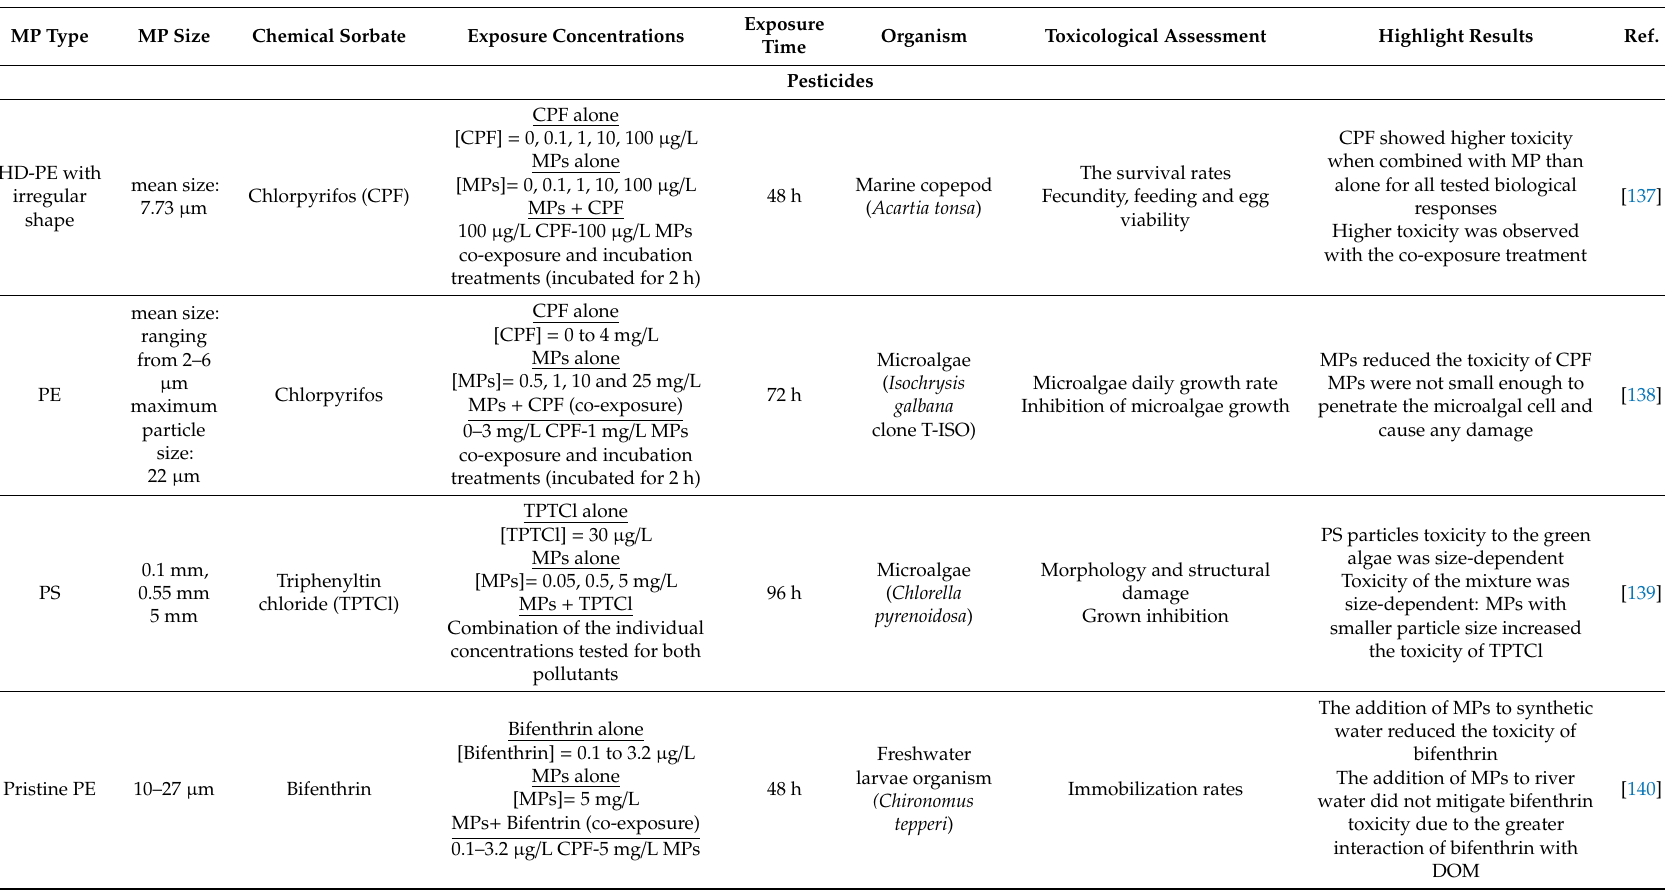
Table 3. Studies assessing the possible synergetic / antagonistic e ff ect of di ff erent types of emerging pollutants combined with